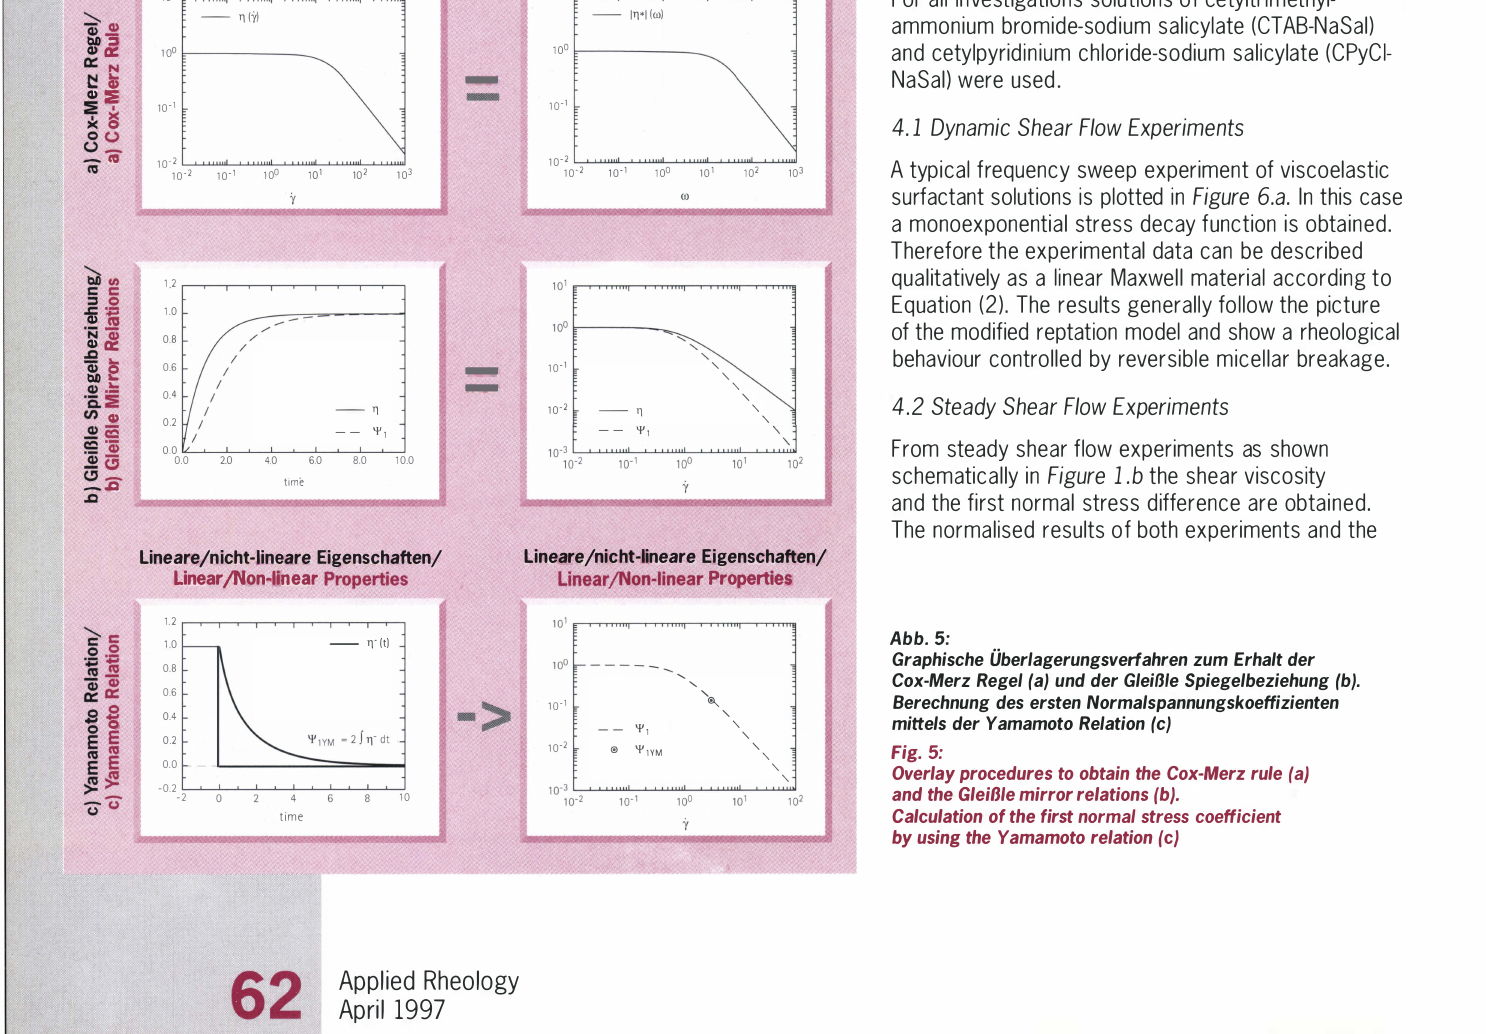
Fig. 5: Overlay procedures to obtain the Cox-Merz rule (a) and the Gleill/e mirror relations (b). Calculation of the first normal stress coefficient by using the Yamamoto relation